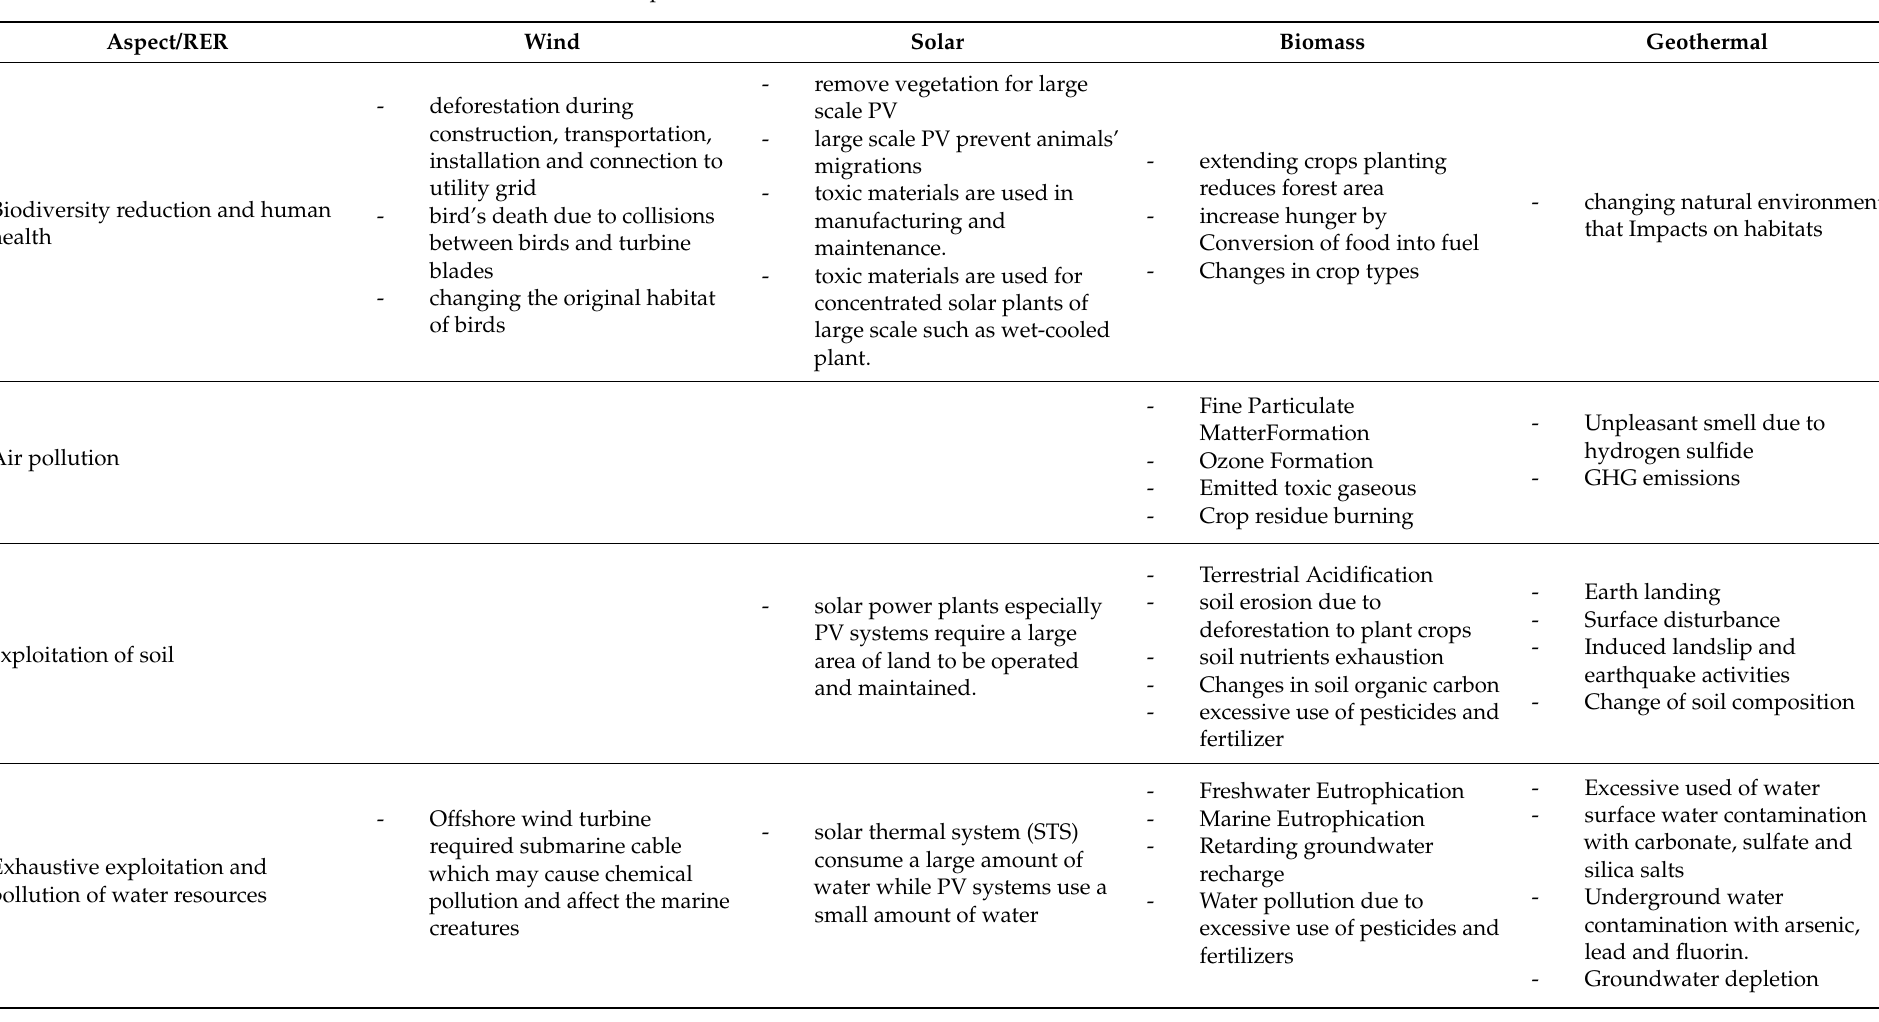
Table 5. Environmental effects comparison for Wind, Solar, Biomass and Geothermal